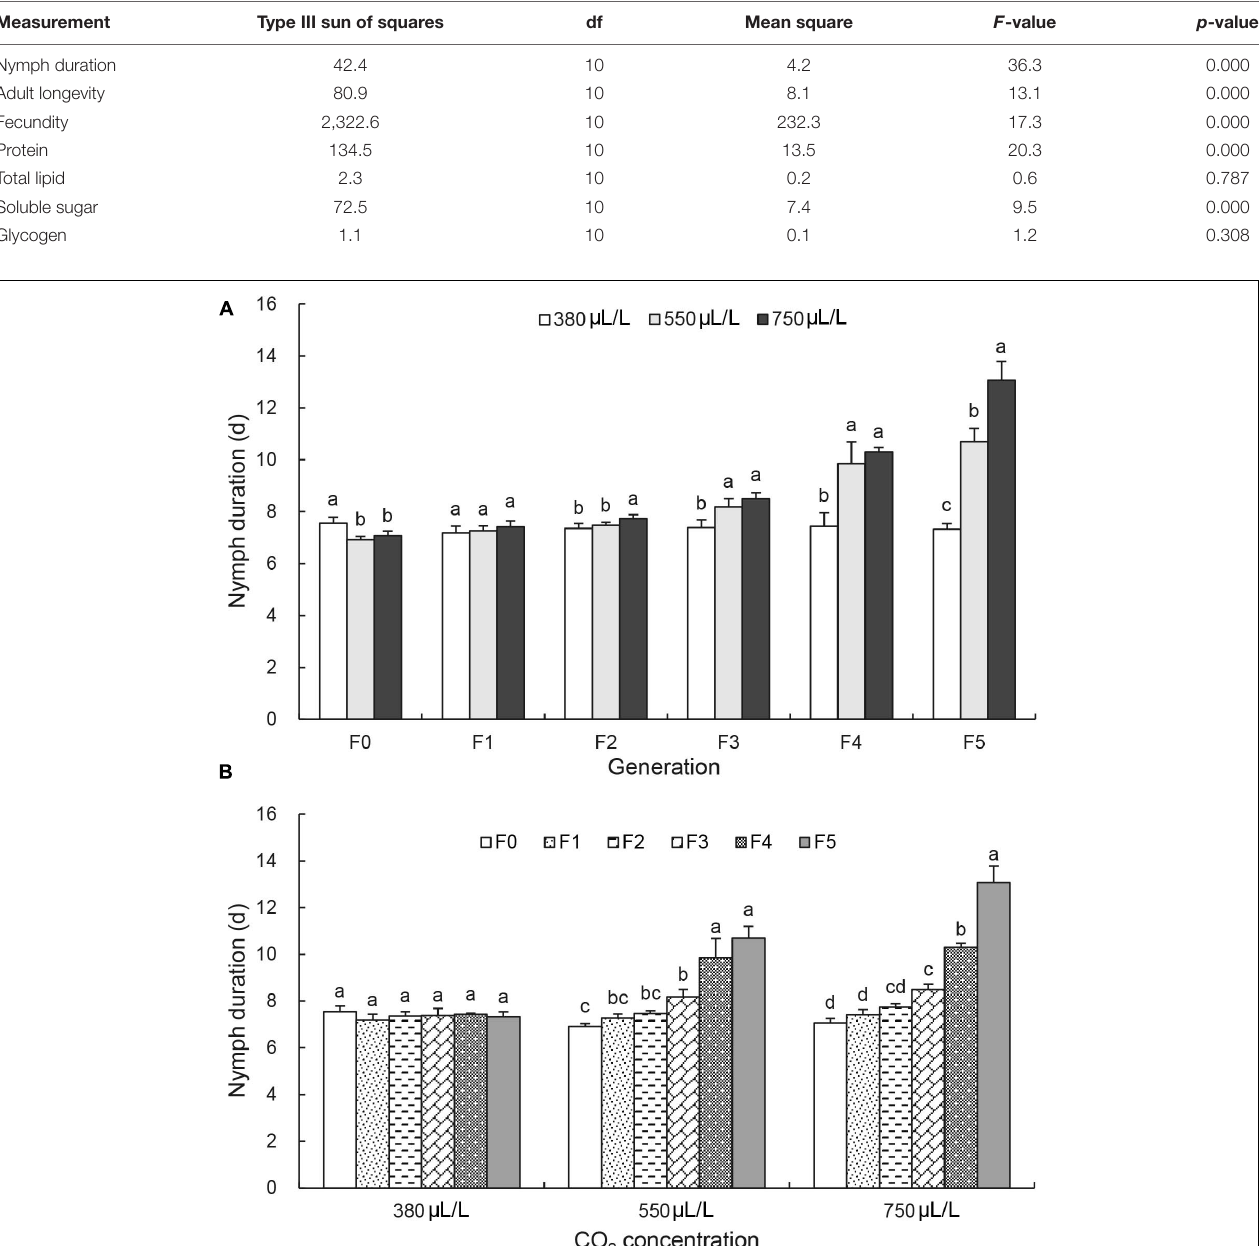
TABLE 1 | Two factors ANOVA analysis of the effect of CO 2 *generation interaction on performance indices in Acyrthosiphon pisum. Measurement Type III sun of squares df